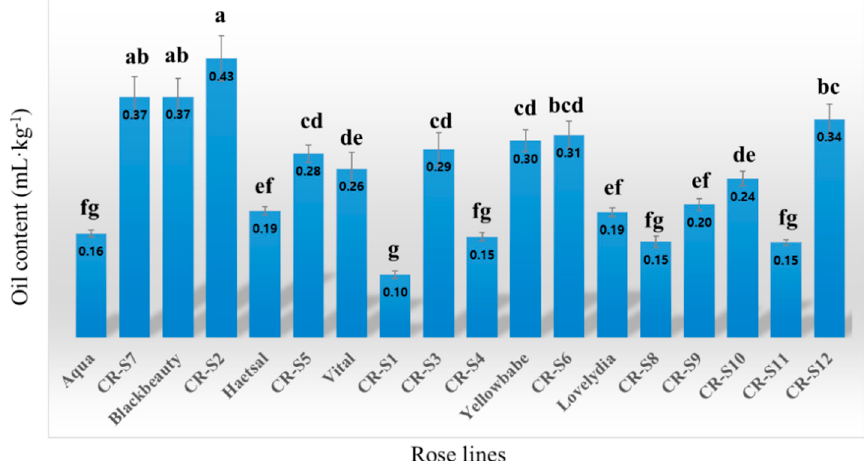
Figure 2. Oil yield of flower for rose mutants and their original cultivars. The letters above each point indicate a significant difference at the 5% level (Duncan’s multiple range tests, n = 3).